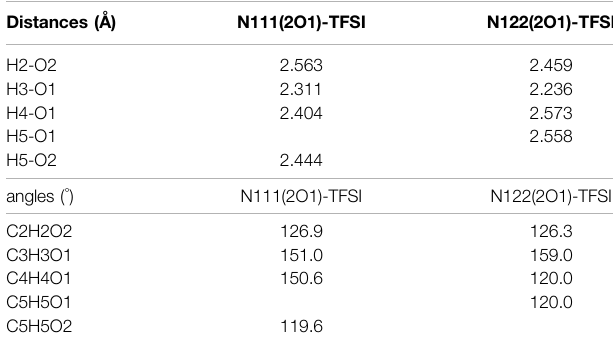
TABLE 1 | The most signi fi cant HO distances (in Å) and CHO angles (in ° ) in N111(2O1)-TFSI and N122(2O2)-TFSI ionic couples, as obtained by DFT calculations with the 6-31G** basis set and the ω B97X-D functional, including empirical dispersion corrections and the presence of a polar solvent (dimethylformamide, ε r = 37.22). Atom labels refer to Figure 2